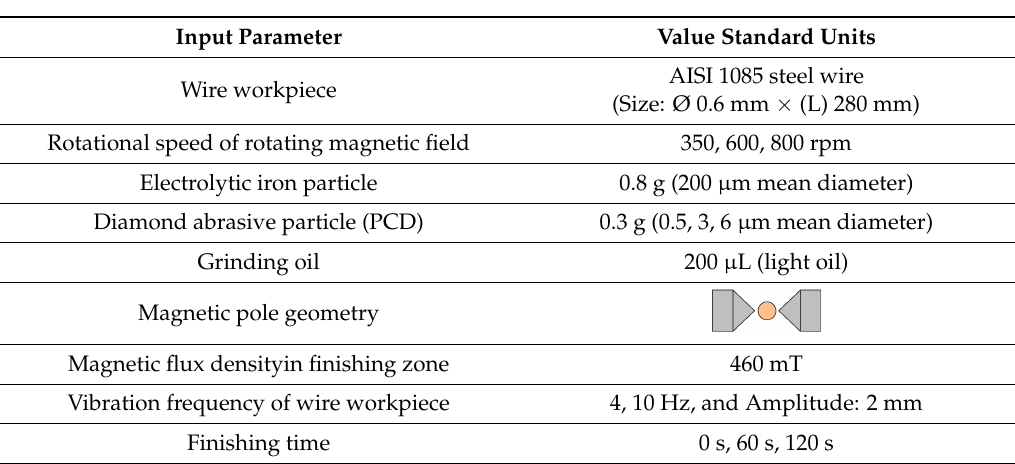
Table 3. Experimental conditions.